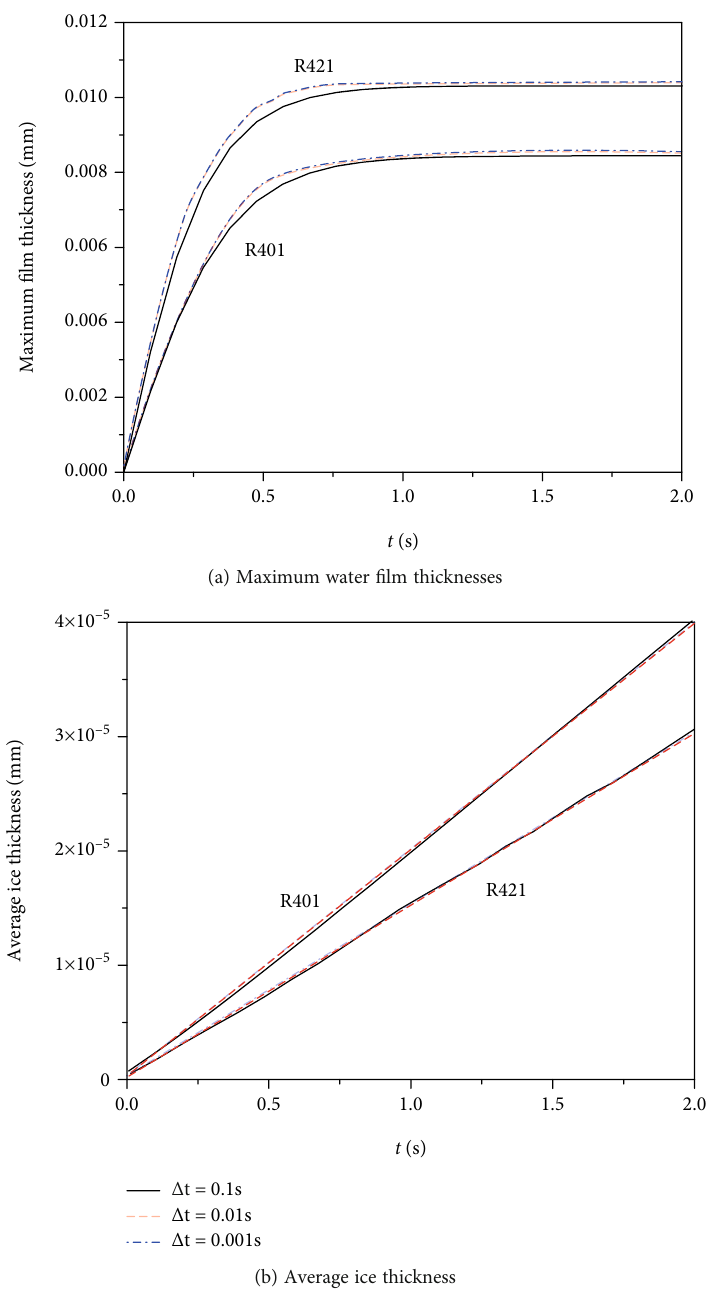
Figure 2: Results at di ff erent time